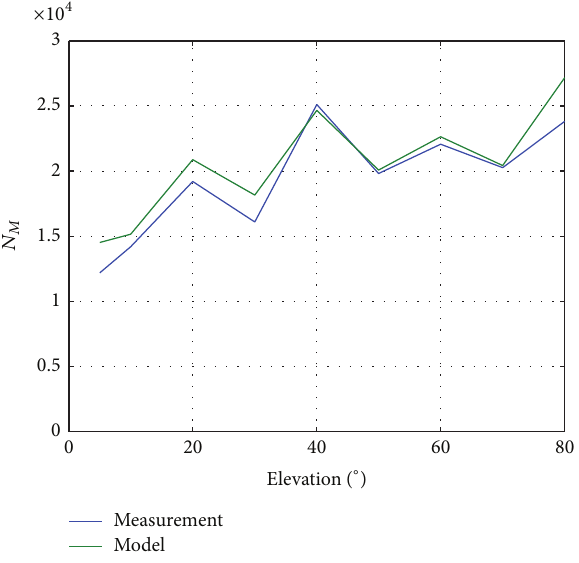
Figure 25: Comparison of normalized echo signal sample count.